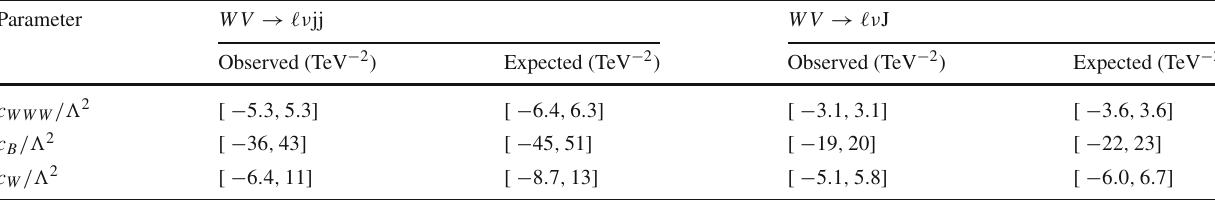
Table 7 The observed and expected 95% confidence intervals for the EFT parameters. The parameters are given in units of TeV − 2 . The confidence intervals for each parameter are calculated while fixing the other parameters to